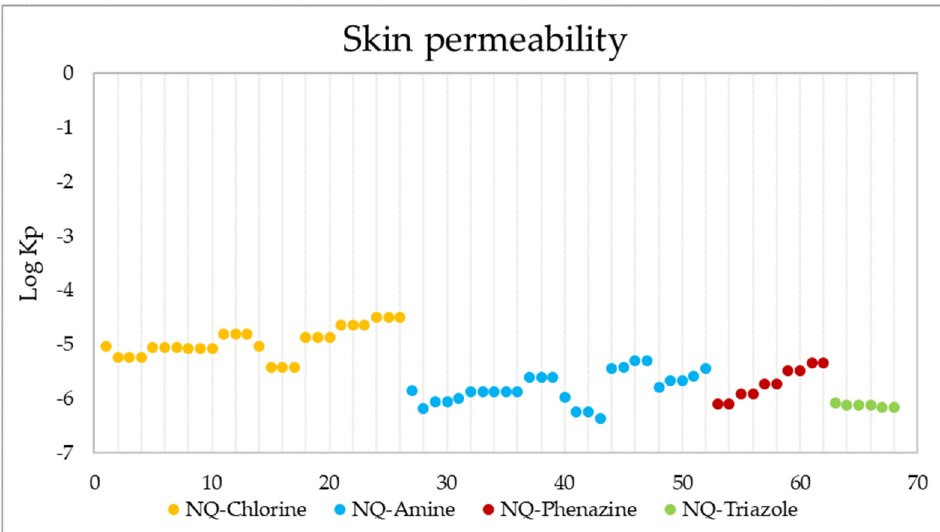
Figure 14. Skin permeability values in Log Kp (Kp in cm/s) of the 68 derivatives. The main enzyme isoforms CYP1A2, CYP2C19, CYP2C9, CYP2D6, and CYP3A4 [98]